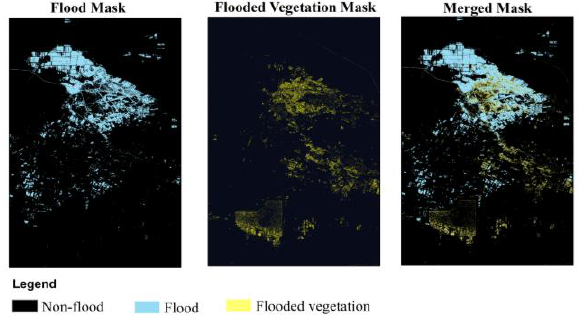
Figure 4 . Flood, flooded vegetation and merged masks for the Sardoba area.